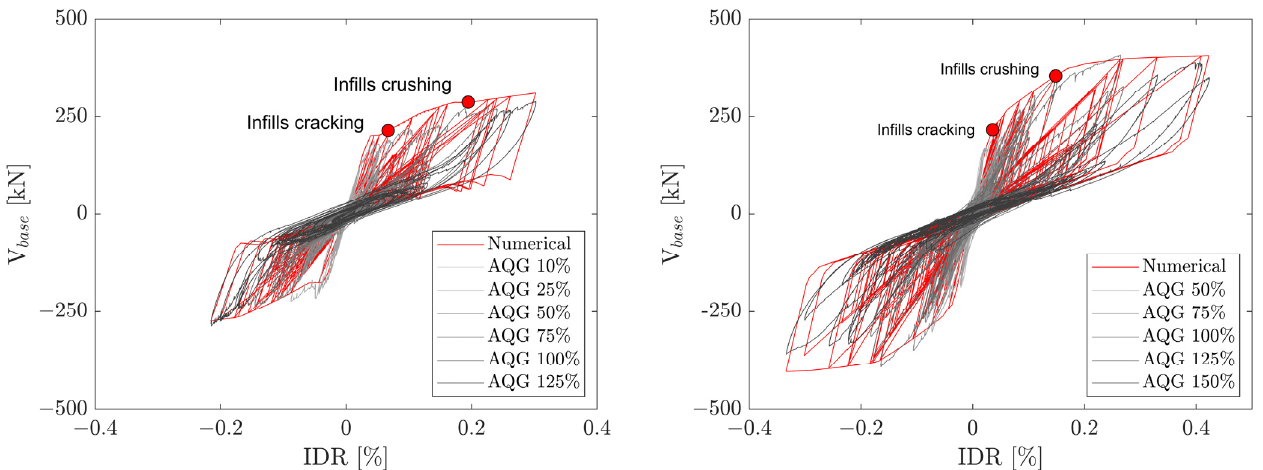
Figure 7. Numerical vs. experimental comparison of hysteretic curves for tests F2_3S_M and F2_4S_M.